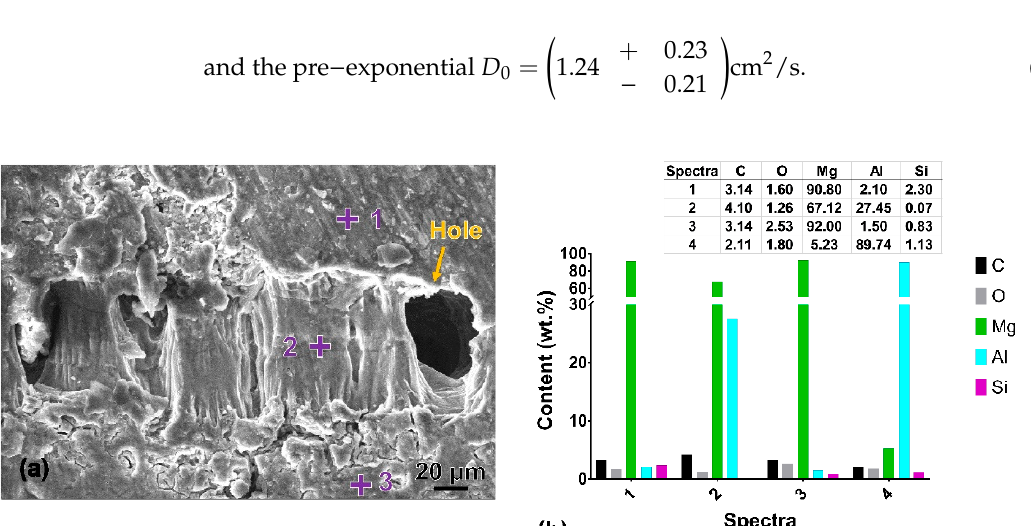
Figure 14. ( a ) Enlarged view of the thermal crack and ( b ) the elemental composition analyses of the spectra numbered 1 to 3.